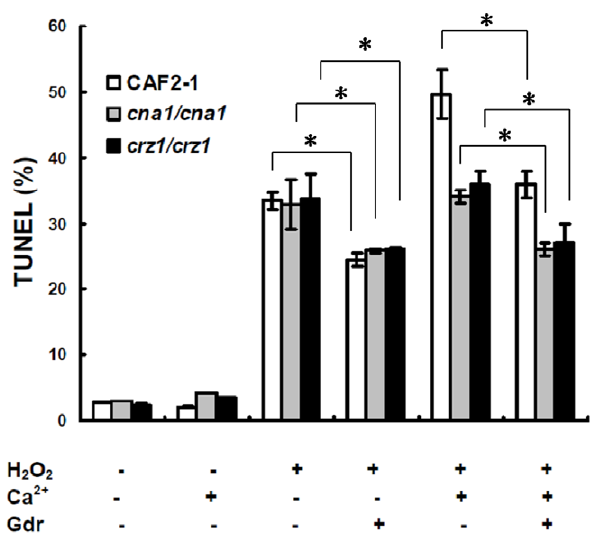
Figure 9. The impact of compromised Hsp90 on calcinerin- pathway-defect cells. C. albicans cells were treated with 1.25 mM H 2 O 2 for 3 h in the absence or presence of CaCl 2 (1 mM) or GdA (0.5 m M). Data are shown as mean 6 SD from three independent experiments. * indicates p , 0.05 compared to the same strain, same H 2 O 2 and CaCl 2 treatment, and without GdA treatment.